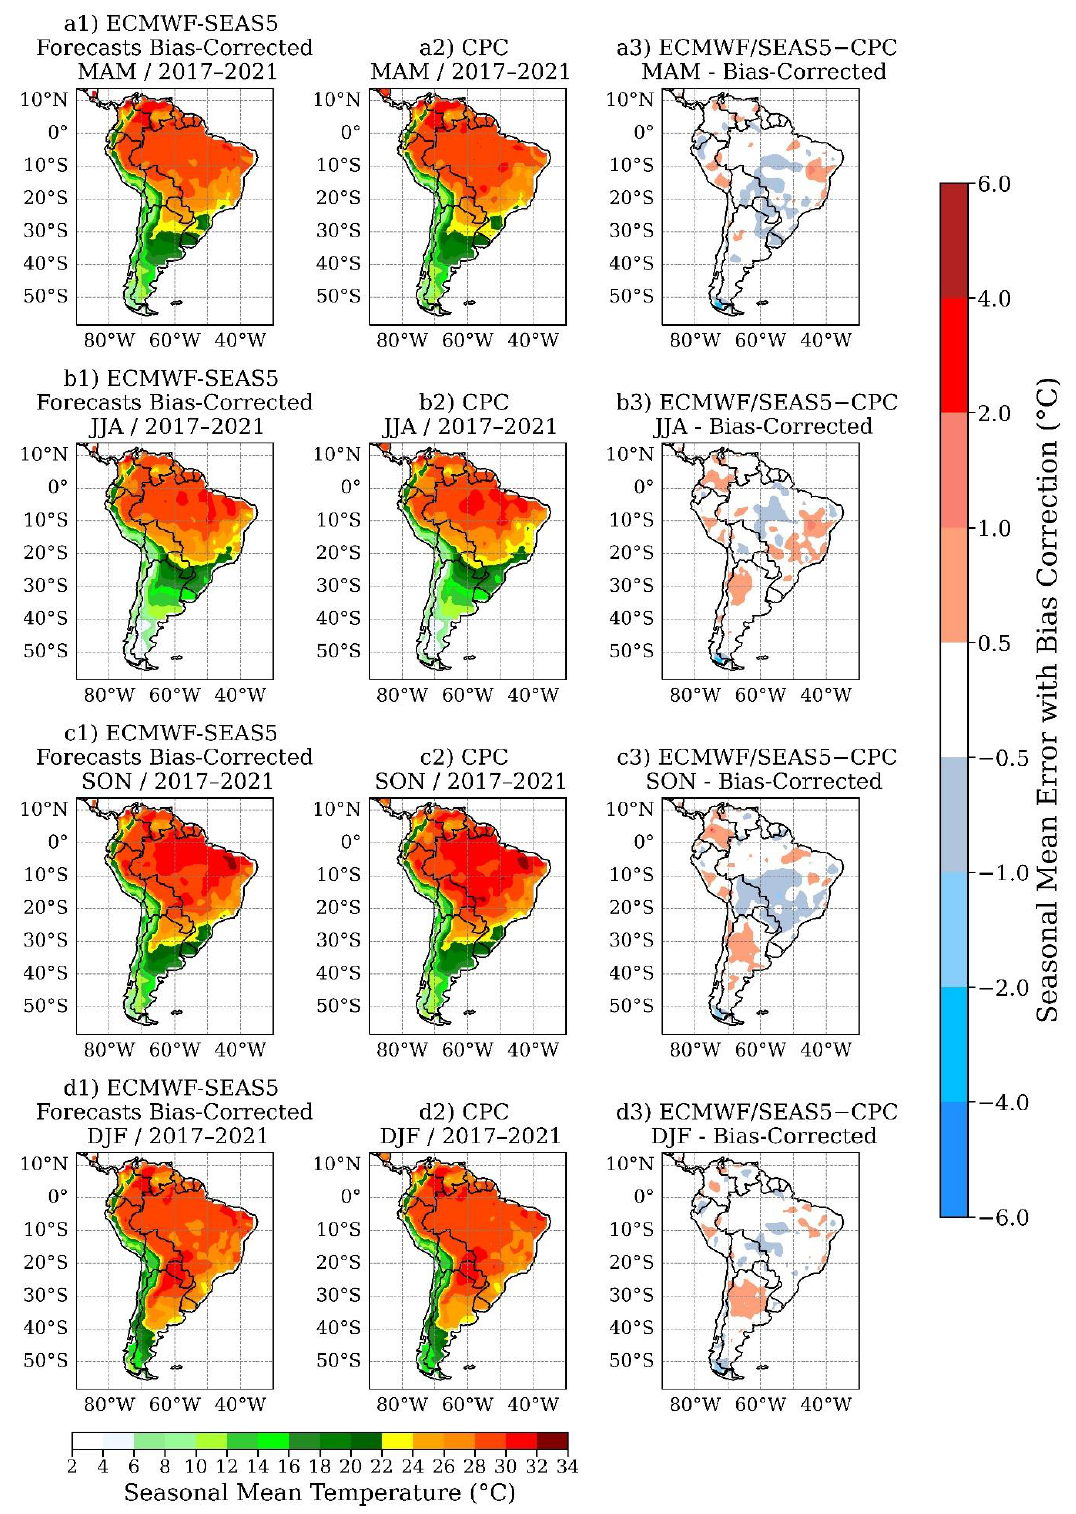
Figure 5. Left column : seasonal mean 2-m temperature ( ◦ C) derived from the ECMWF-SEAS5 forecasts after bias correction, averaged over the 2017–2021 period and the 51 ensemble members, for ( a ) MAM, ( b ) JJA, ( c ) SON, and ( d ) DJF. Center column : CPC seasonal mean surface temperature ( ◦ C) averaged over 2017–2021. Right column : seasonal temperature mean errors ( ◦ C) obtained by the difference between ECMWF-SEAS5 seasonal forecasts after bias correction and CPC, averaged over